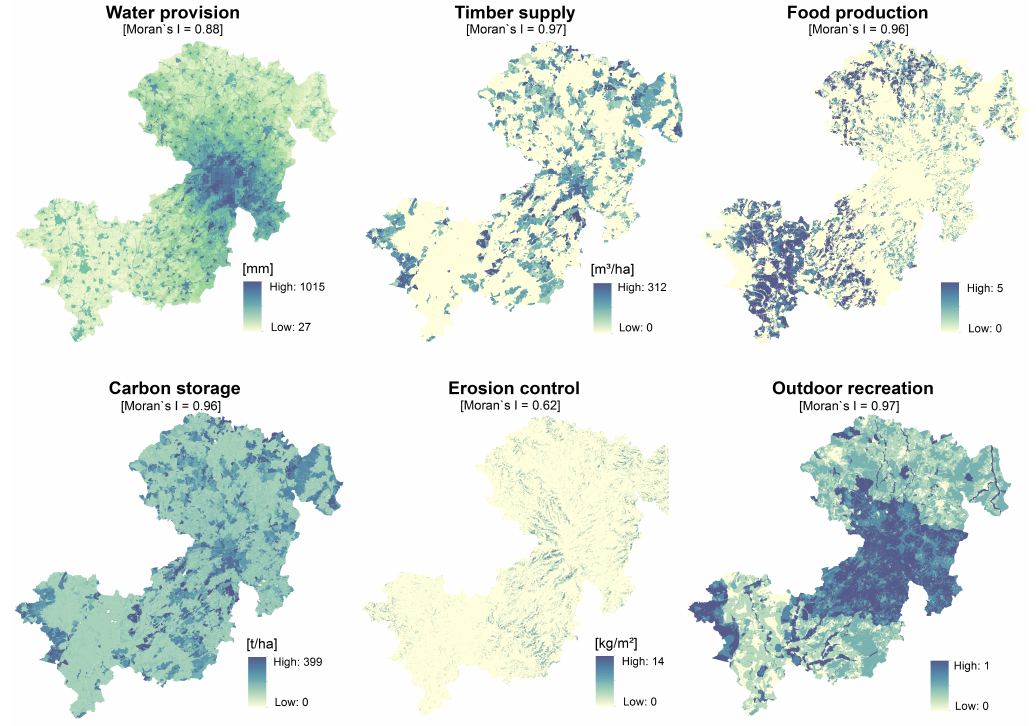
Figure 2. Spatial distribution of ecosystem services in the study area (10 m ˆ 10 m